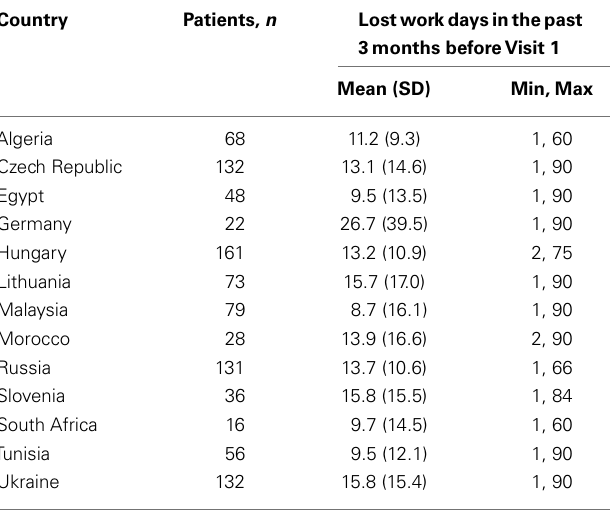
Table 4 | Mean number of lost work days among employed patients in the past 3months beforeVisit 1 by